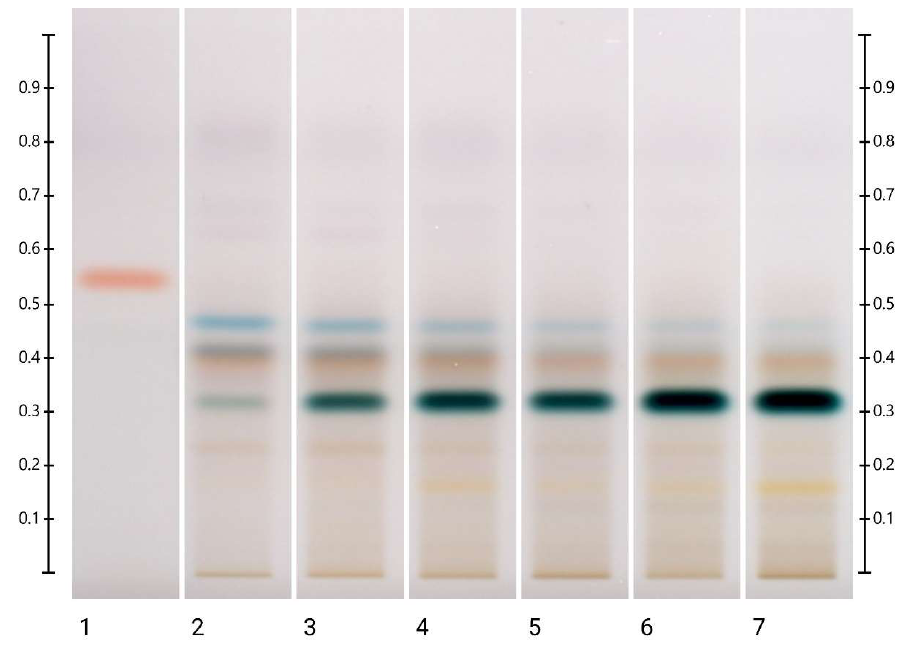
Figure 3. LEP long-term storage at 60 °C. Images taken under white light after derivatisation with vanillin reagent; Track 1—4,5,7-trihydroxyflavanon, Track 2—0 h, Track 3—1 month, Track 4—2 months, Track 5—3 months, Track 6—4 months, and Track 7—5 months; 5 μL of each honey extract, respectively.